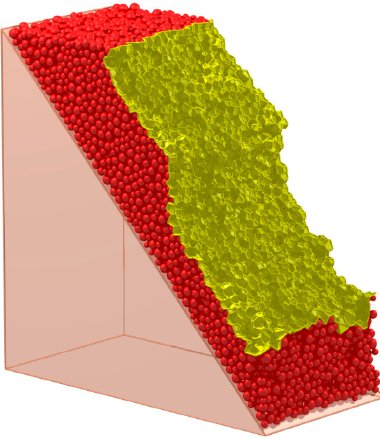
Figure 18. The interface between the bottom cluster and the other clusters.